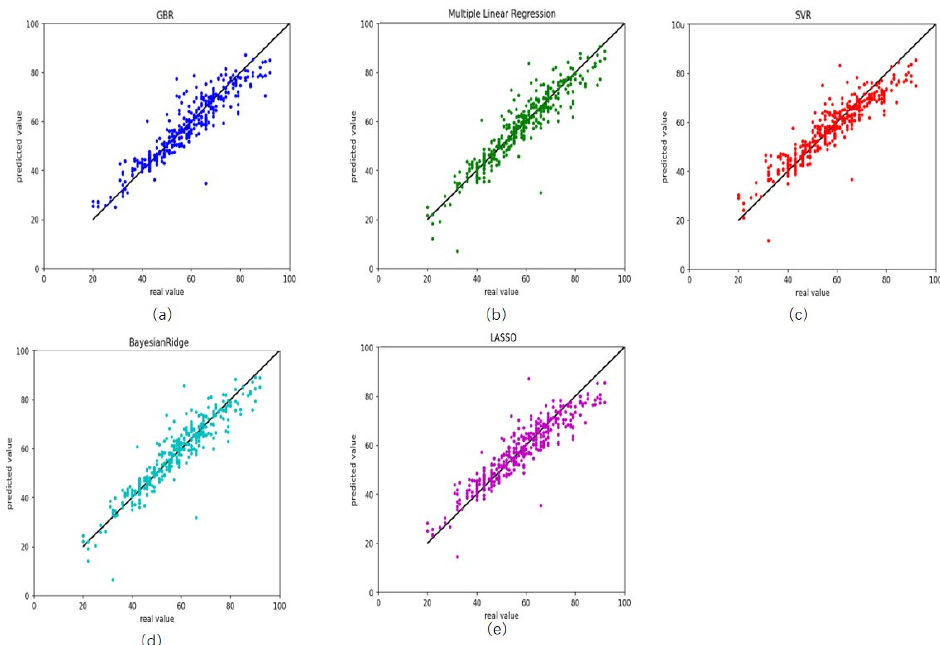
Figure 2. Comparison results between the actual age and predicted age by five different models on the testing healthy data. ( a ) gradient boosting regression, ( b ) multiple linear regression, ( c ) support vector regression, ( d ) Bayesian ridge regression and ( e ) lasso regression.